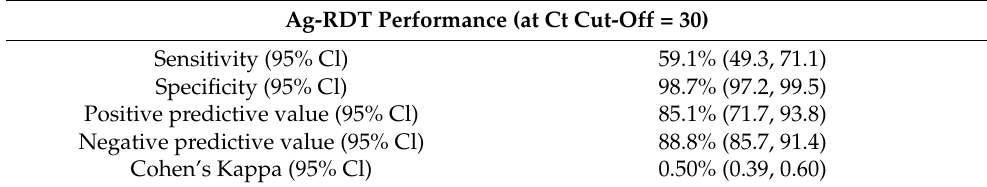
Table 2. Performance of the Ag-RDT compared with a PCR reference standard, with a Ct cut-off of